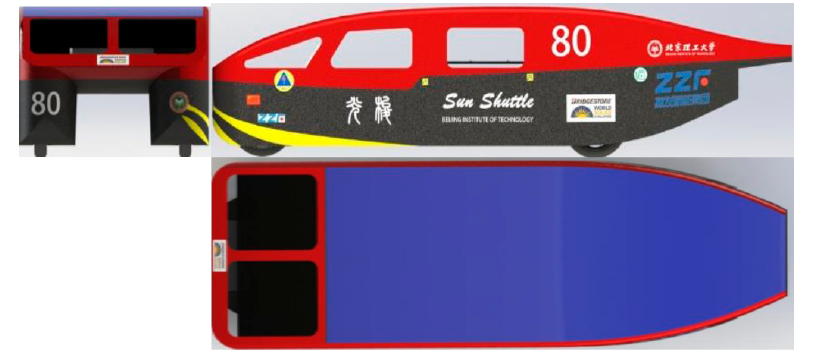
Figure 2. Appearance of “Sun Shuttle III”. Table 1. Specifications of “Sun Shuttle III”.